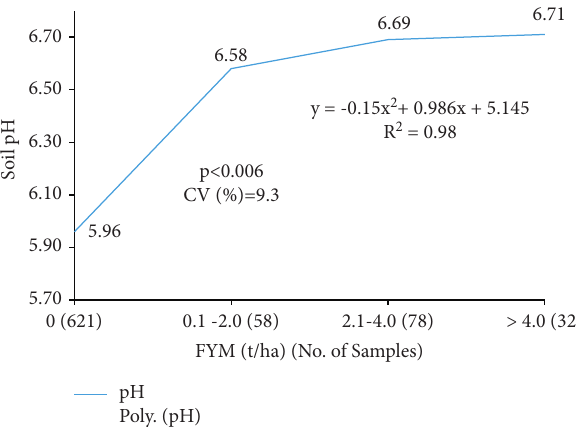
Figure 4: pH level on crop fields that received different rates of farmyard